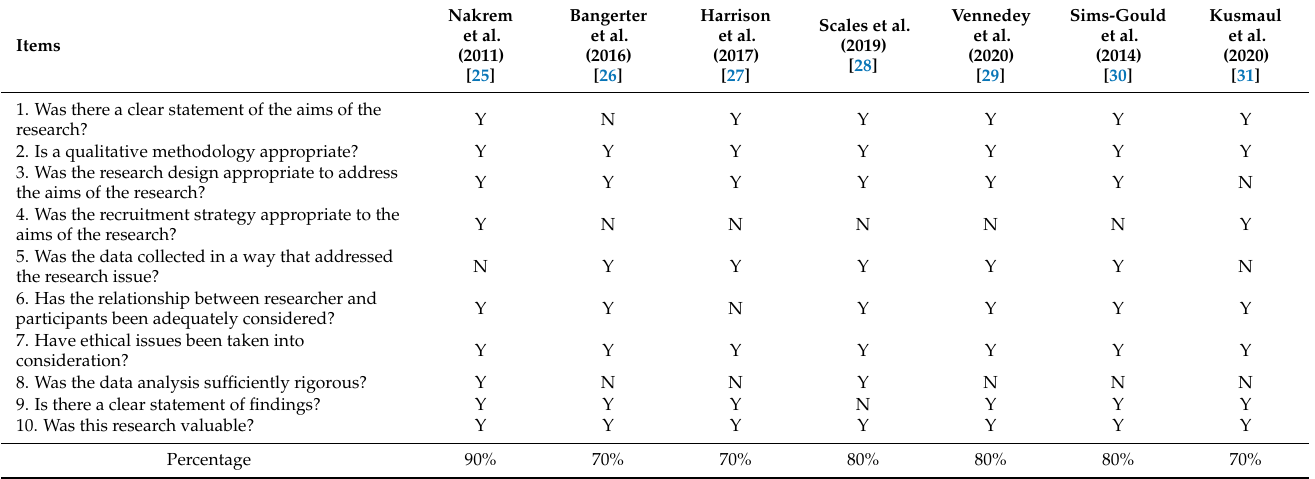
Table 1. Quality assessment results of the Critical Appraisal Screening Program using the in- cluded